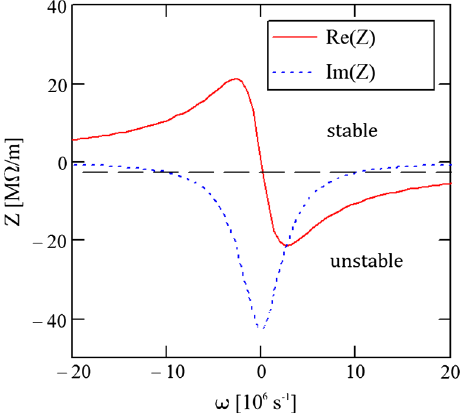
FIG. 11. Real and imaginary parts of impedance as a function of a mode angular frequency ω . The dashed line represents the Landau damping. The modes with Re ½ Z ð ω Þ(cid:2) below the dashed line are unstable.